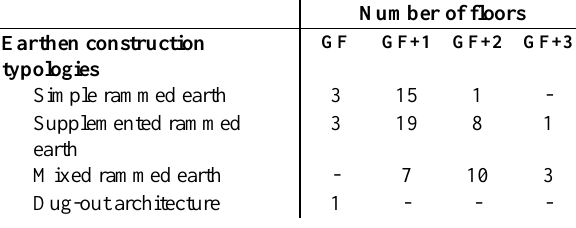
Table 2. The relation between earthen construction typologies and building elevation.